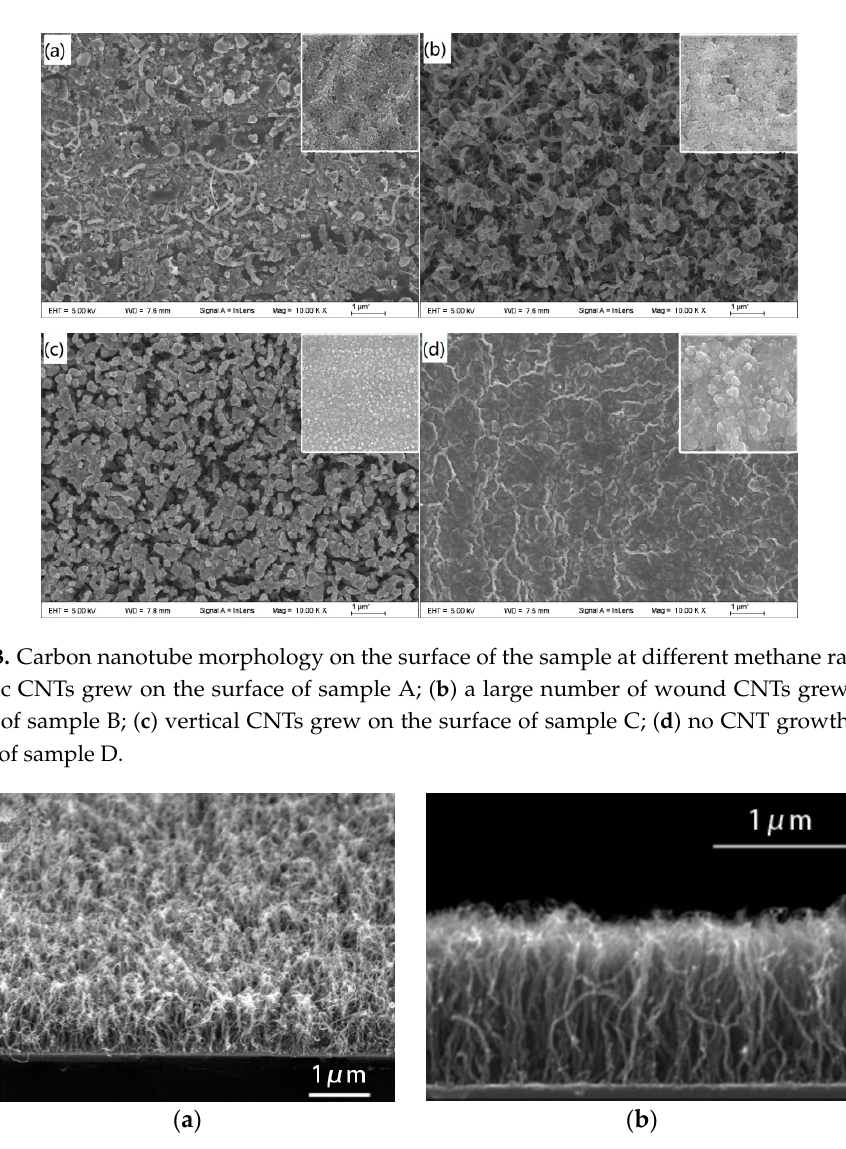
Figure 4. Cross-sectional SEM image of the grown carbon nanotube samples: ( a ) A large number of wound CNTs grew on the surface of sample B; ( b ) vertical CNTs grew on the surface of sample C.